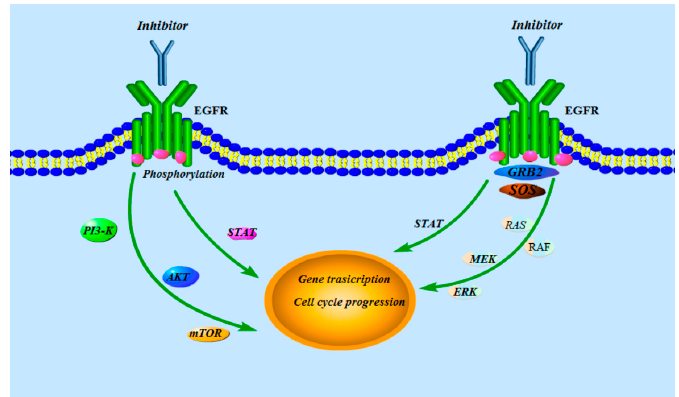
Figure 2. The signal transduction pathway of EGFR.